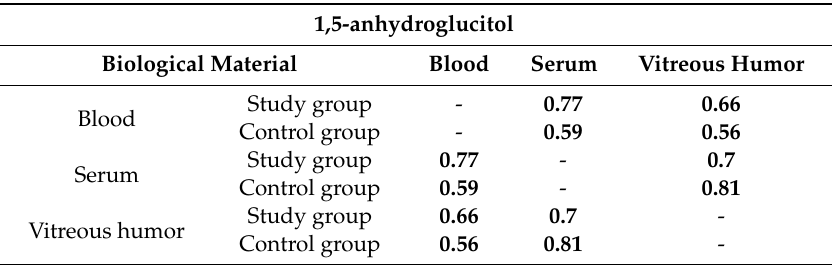
Table 13. Correlation between 1,5-anhydroglucitol concentration in di ff erent biological materials. Significant correlations are in